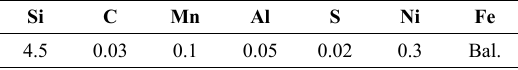
Table 1. Chemical composition of the material (Weight